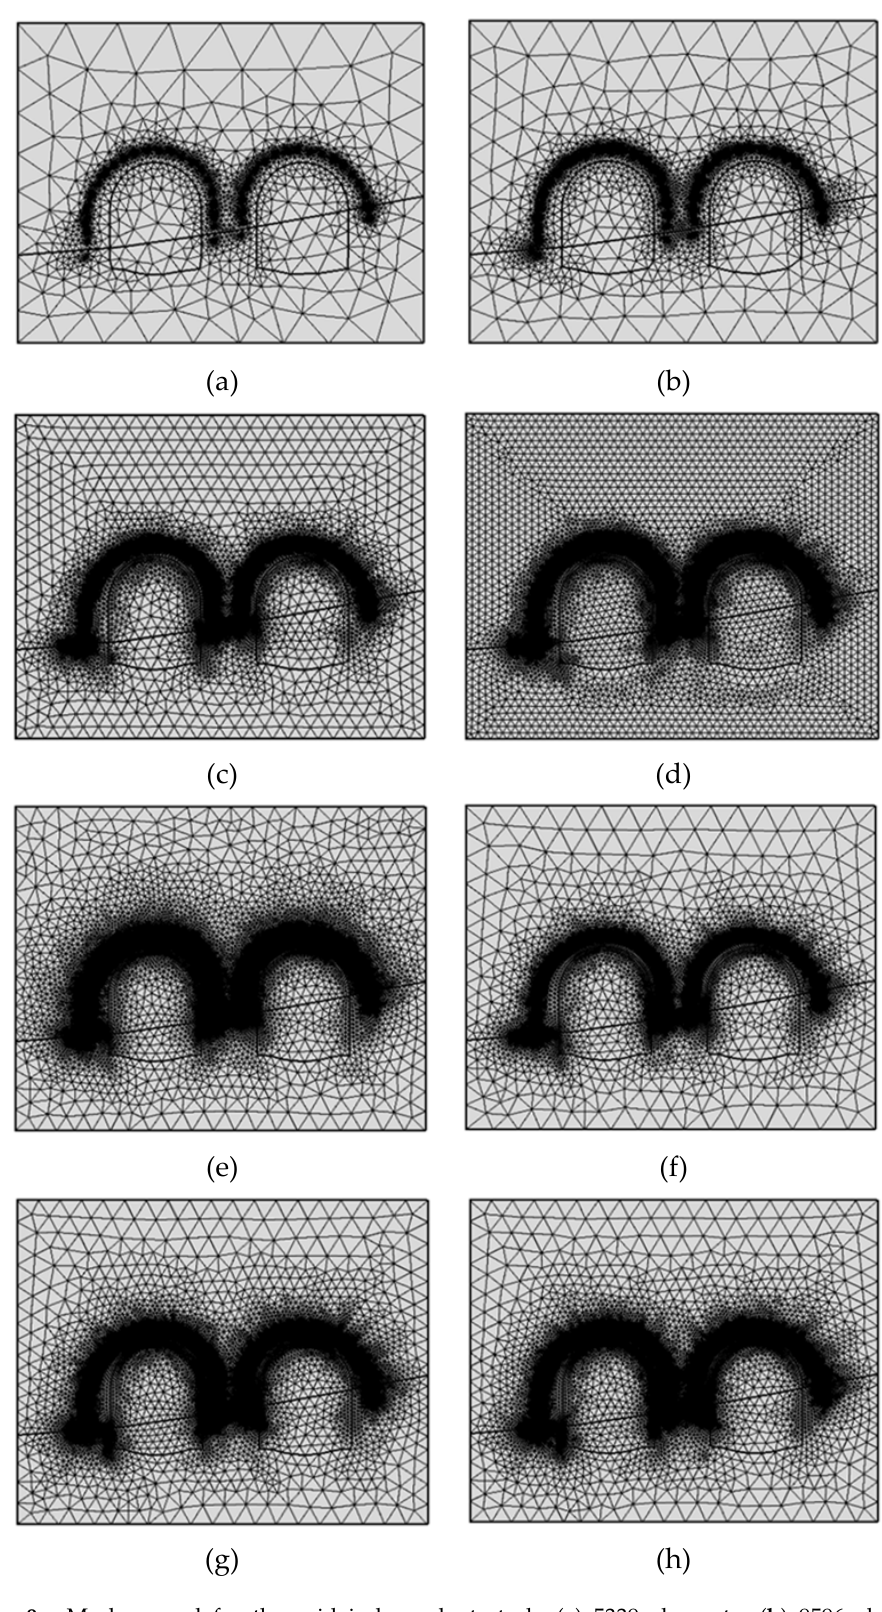
Figure 9. Meshes used for the grid independent study ( a ) 5339 elements; ( b ) 9596 elements; ( c ) 42,671 elements; ( d ) 73,804 elements; ( e ) 82,046 elements; ( f ) 103,482 elements; ( g ) 113,342 elements; ( h ) 177,964